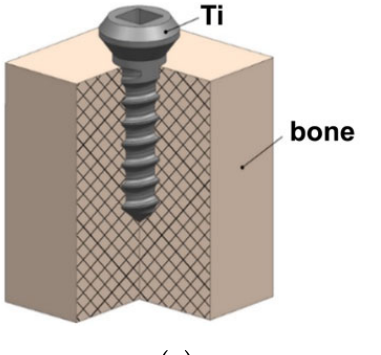
Figure 2. Solid ( a ) and mesh ( b ) models of a screw with a bone fragment, and the respective loading principle ( c ).